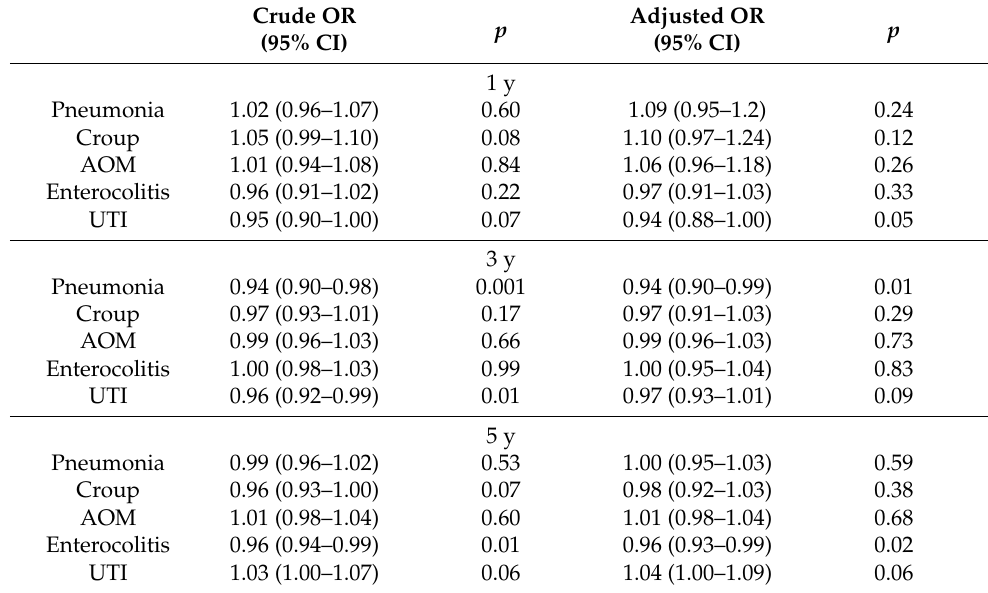
Table 4. Association between serum zinc concentration and clinical infectious outcome throughout the first 5